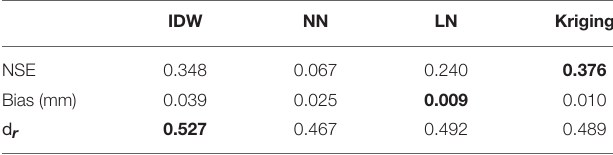
Bold numbers indicate the best performance at each station.